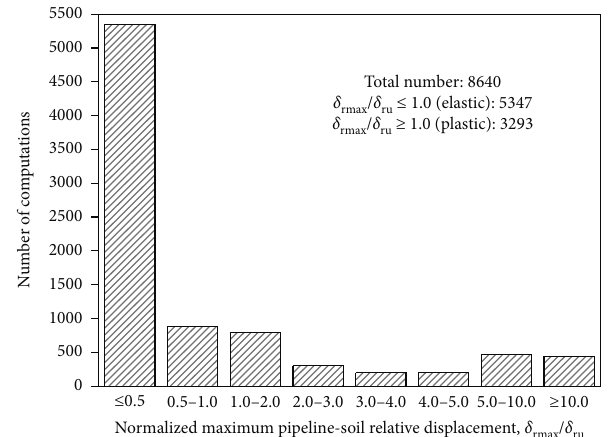
Figure 7: Statistical analysis results of maximum relative pipeline-soil displacement.